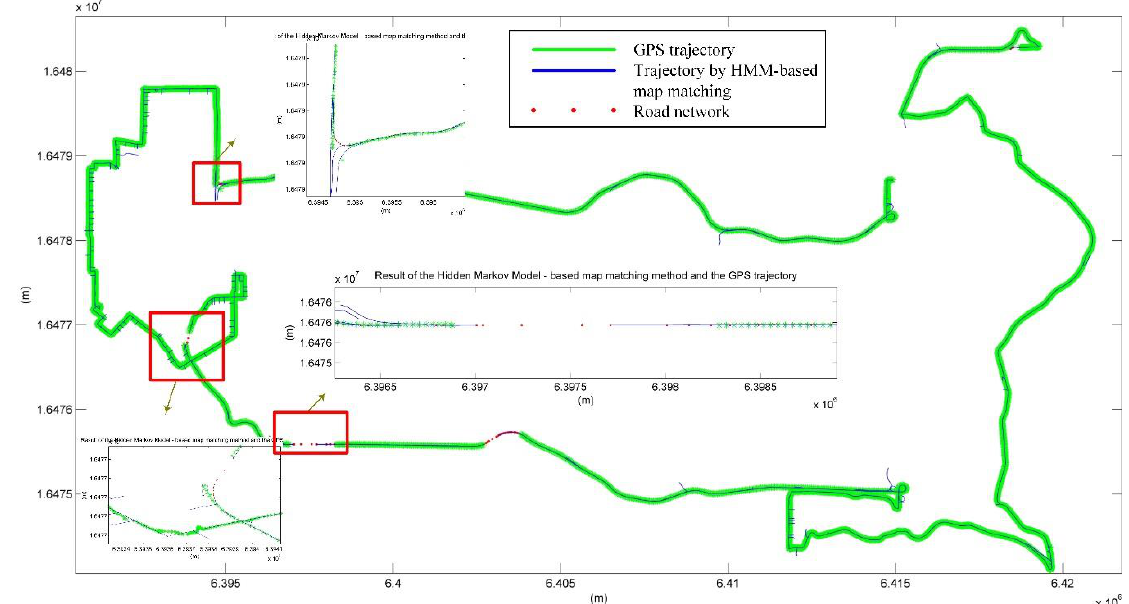
Figure 10. Result of the HMM-based map-matching method and the GPS trajectory.